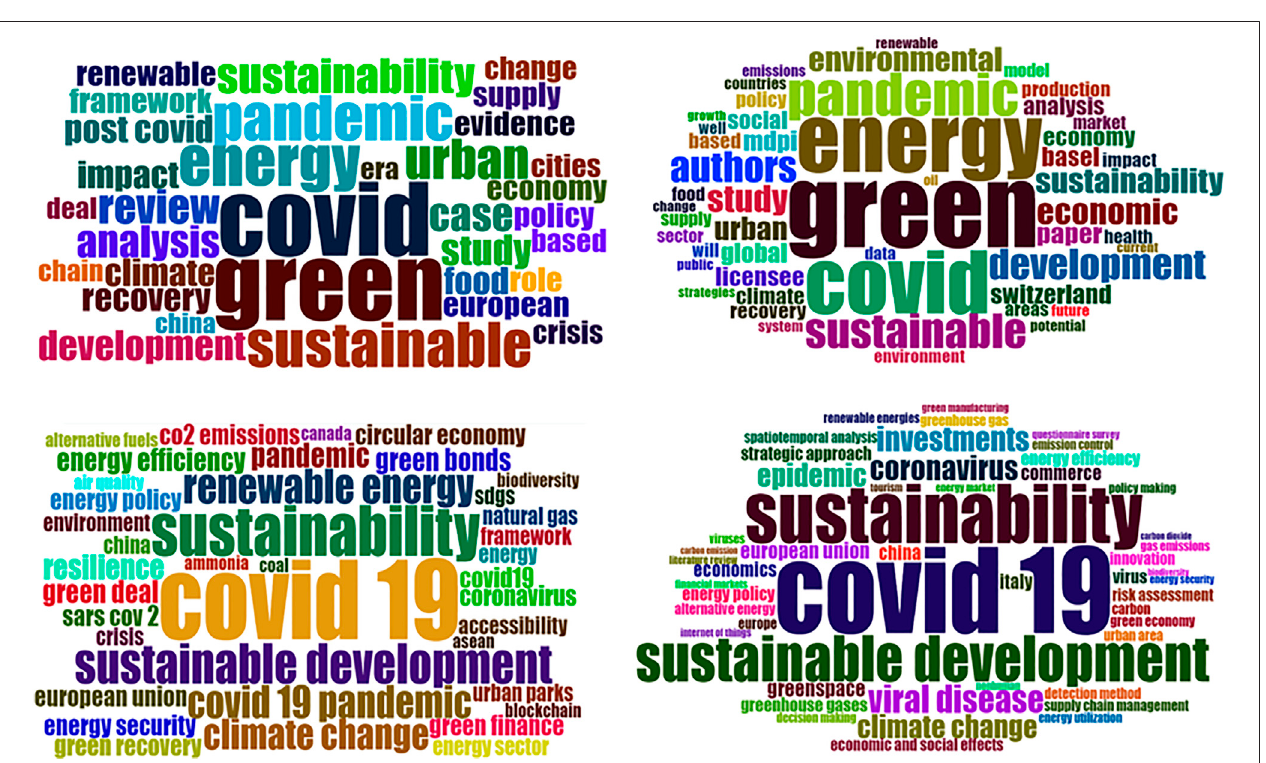
FIGURE 3 | Abstract keywords, title keywords, author keywords, and keywords plus.